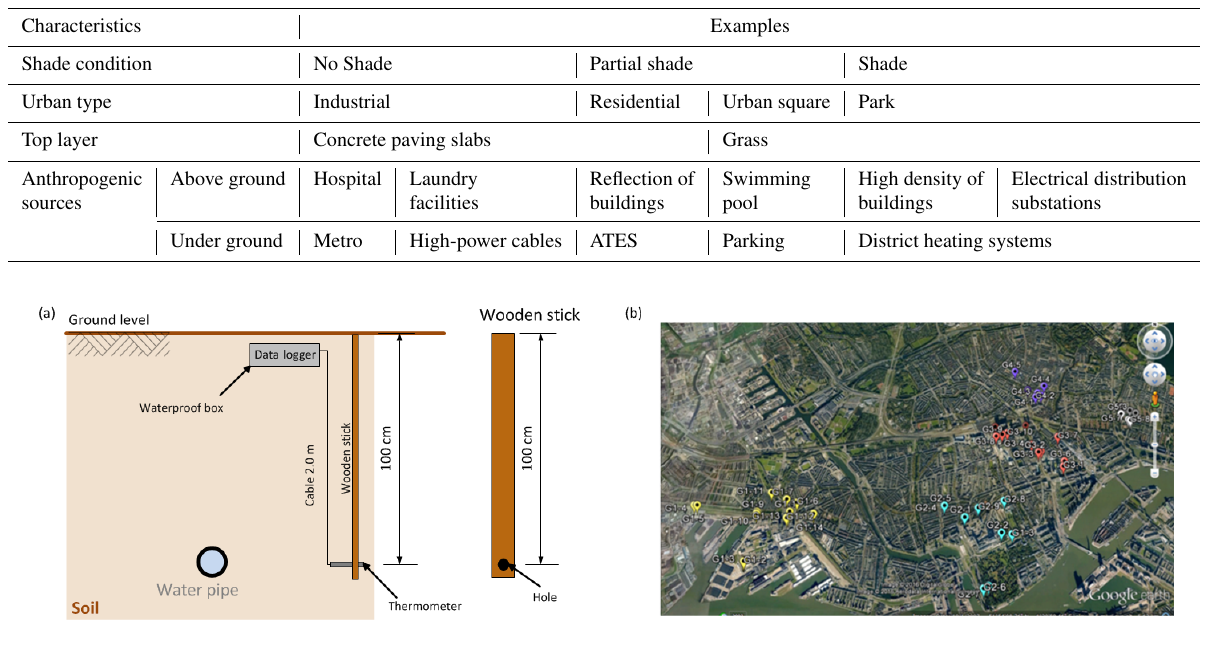
or due to leaks from the sewer or drinking water